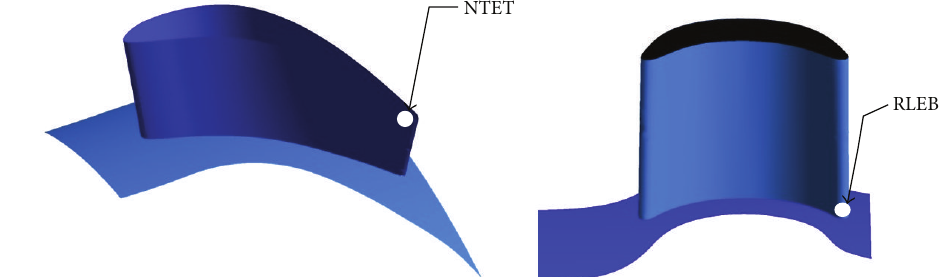
Figure 10: Critical points where thermal stresses were analyzed.